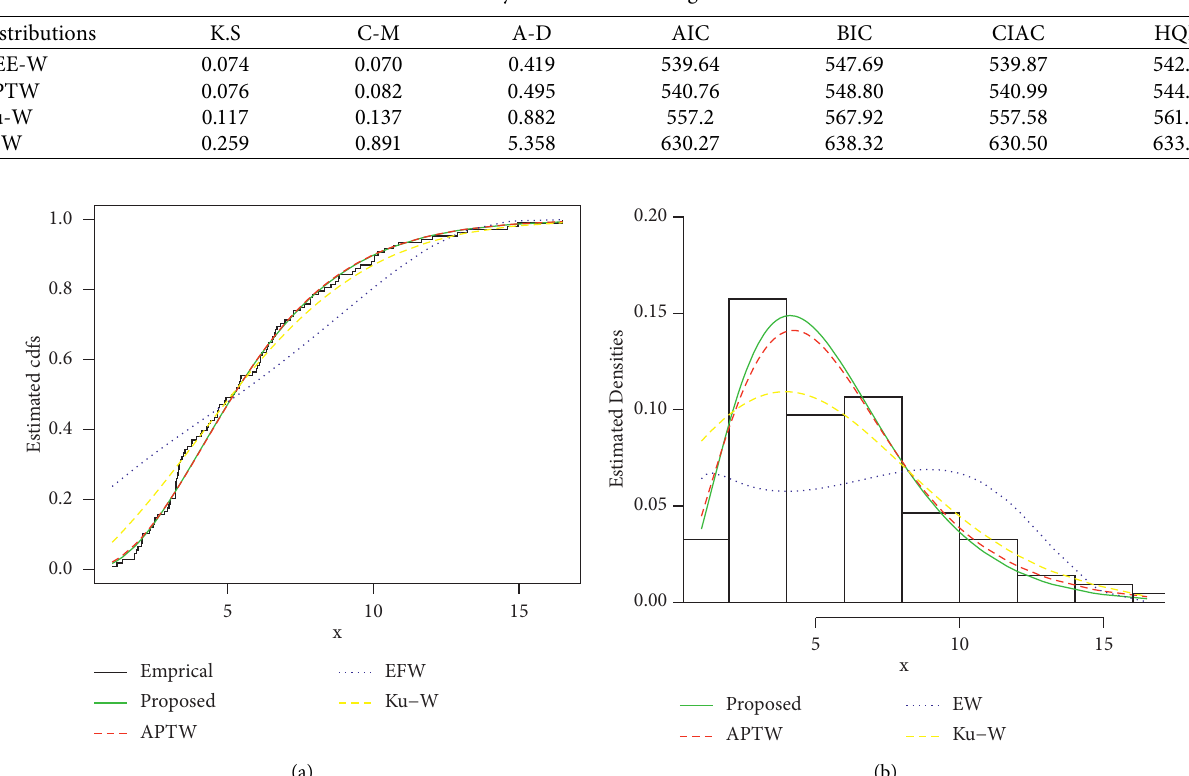
Table 8: Statistics of the analytical measures using COVID-19 data of Mexico.